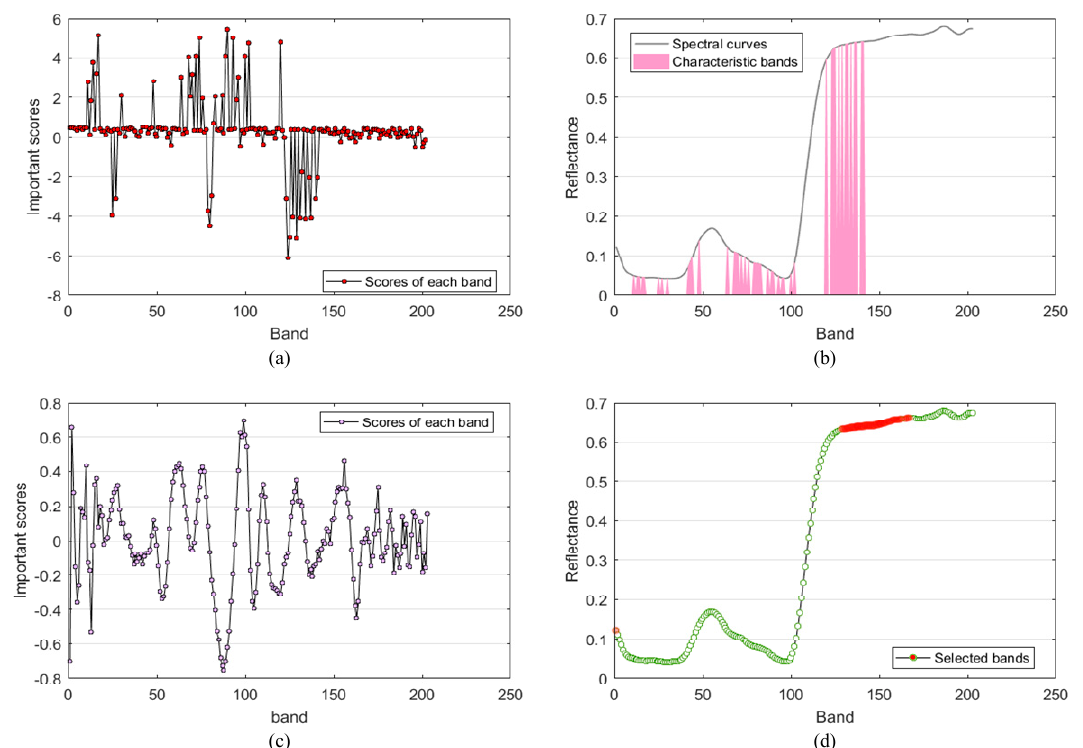
Figure 12. Results of feature band selection. ( a ) The importance score of each feature channel calculated by the Y–Net band selection module. ( b ) The region of the spectral curve where the feature band extracted by the band selection module is located. ( c ) The magnitude of the regression coefficients of each band by PLS calculations. ( d ) Feature bands by SPA selection.